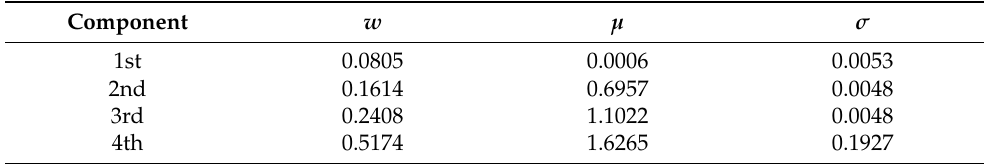
Table 9. The result of parameter estimation for each component of the EV-I mixture distribution on the DHF data in eastern Surabaya.